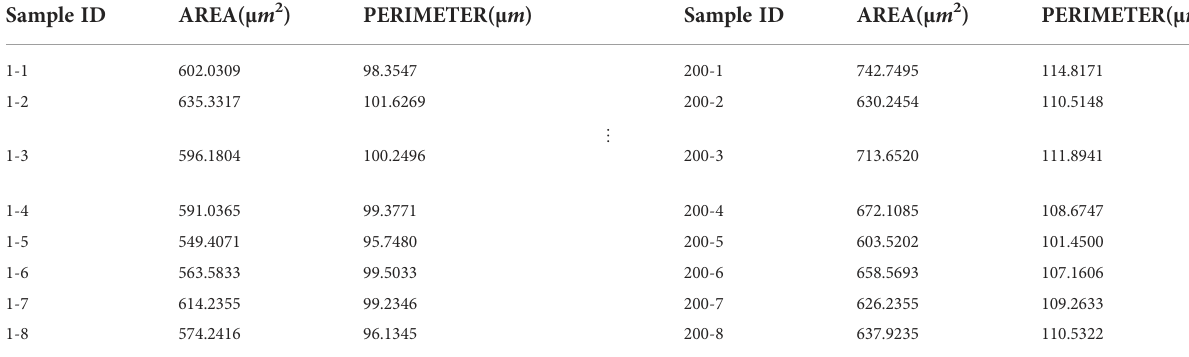
TABLE 4 Features of tracheid morphology.